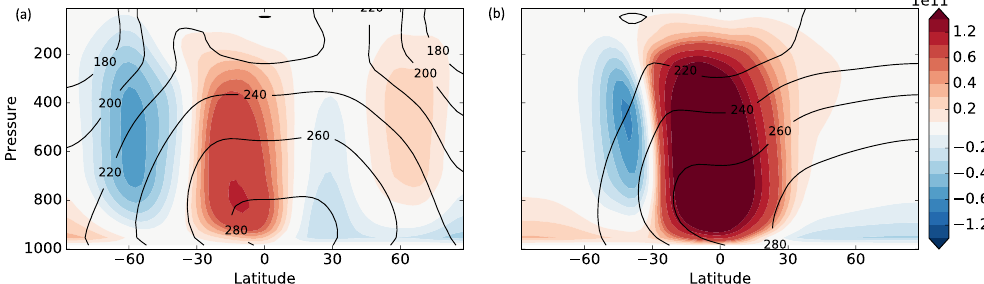
Figure 1. Meridional overturning circulation (colours, 10 11 kgs − 1 ) and temperature (contours, K) in simulations with an obliquity of 10 ◦ (a) and 40 ◦ (b) , at solstice, with Earth-like parameters otherwise, and a mixed-layer depth of 10m. (Earth’s obliquity is 23.5 ◦ .) Note that at the higher obliquity the temperature is a maximum near the